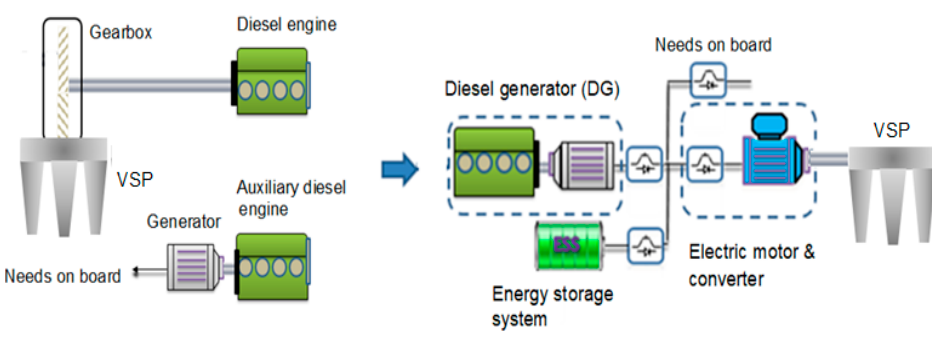
Figure 6. Hybridization strategy.